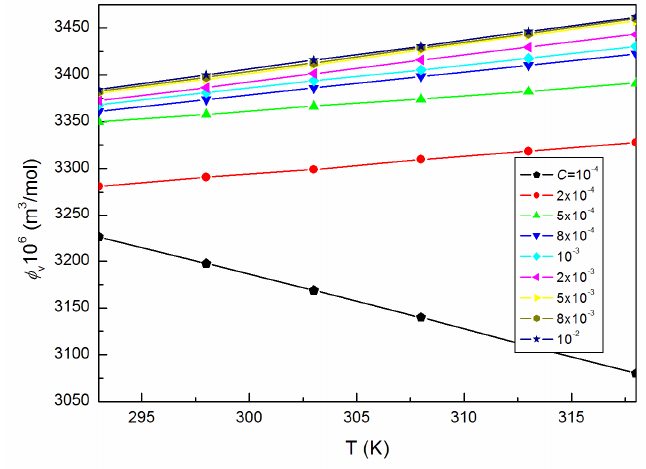
Figure 10. A plot of the values of the apparent molar volume, ϕ V , of the aqueous solutions of ELP at C from 10 − 4 to 10 − 2 M vs. the temperature, T.